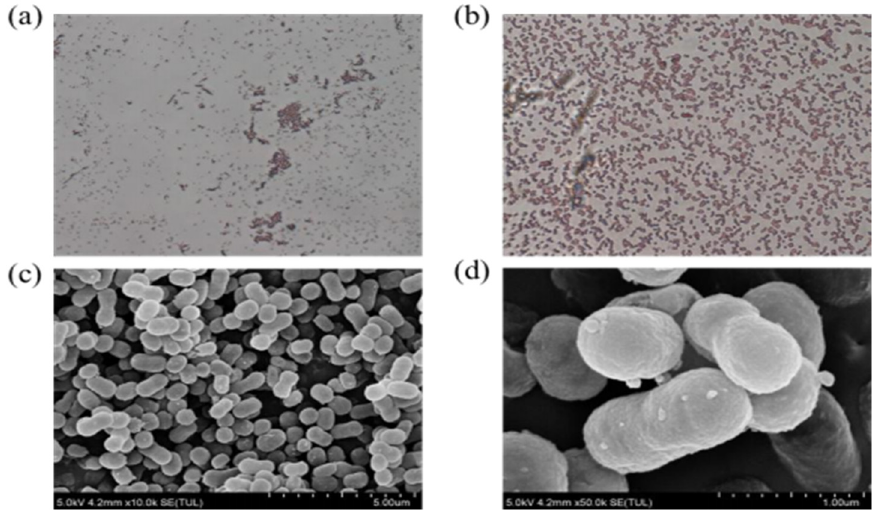
Figure 1. Photographs of cell of strain JYZ-03. ( a , b ) Gram stain photo of JYZ-03 (×20 microscopic view; ×100 microscopic view); ( c , d ) Scanning electron microscope photo of JYZ-03 (5.00 μ m SEM; 1.00 μ m SEM).